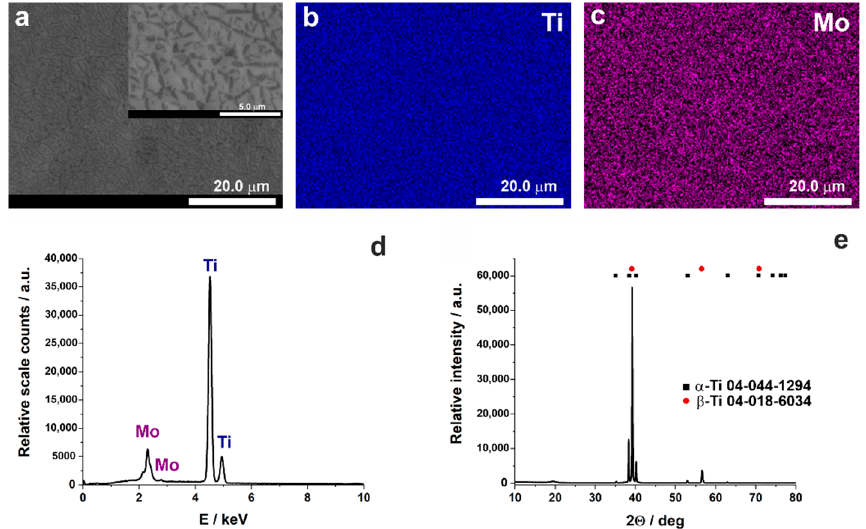
Figure 1. FE-SEM image (low and high (inset) magnification) ( a ), EDS elemental maps ( b , c ), EDS spectrum ( d ), and XRD pattern ( e ) of as-received Ti15Mo substrate prior to anodization process. FE-SEM image reveals that the surface of the material after polishing is relatively smooth with some distinct domains suggesting the coexistence of both β and α phases, that was also confirmed by XRD measurements (see Figure 1e). However, it should be emphasized that, as expected, the β phase is predominant for this alloy, which is consistent with previous reports (e.g., [47]). Moreover, EDS elemental maps (Figure 1b,c) show a uniform distribution of both elements (Ti and Mo). The alloy composition was verified to be 75 wt.% and 15 wt.% for titanium and molybdenum, respectively. Such a